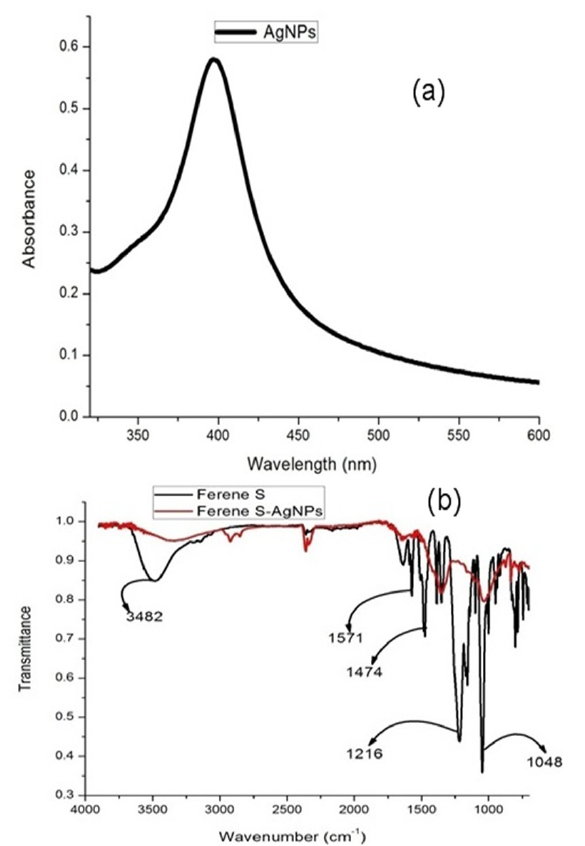
Figure 1. ( a ) UV-visible absorption spectrum of Ferene-S-AgNPs ( b ) Comparative FTIR spectra of Ferene-S and